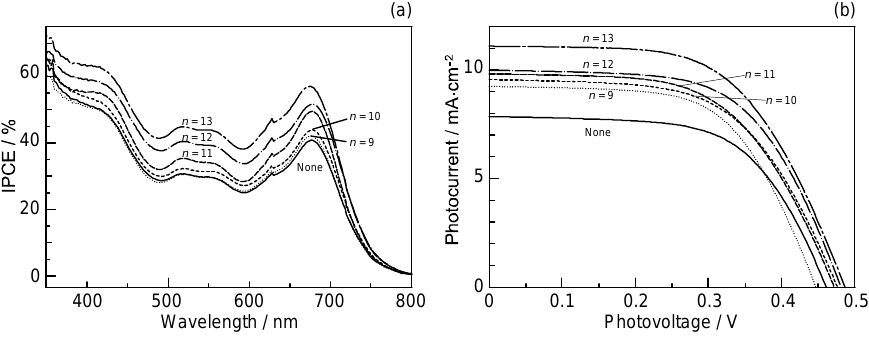
Figure 19. (a) The IPCE profiles and (b) the I–V curves of the Phe a -sensitized solar cells in the absence and presence of the Car redox spacer including neurosporene, spheroidene, lycopene, anhydrorhodovibrin or spirilloxanthin with n = 9~13 (reprinted from [16], Copyright (2005), with permission from Elsevier).